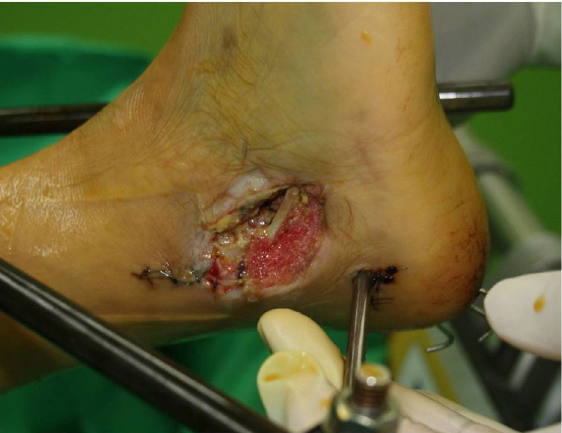
Figure 1. An external fixator with multiple pins and bars may theoretically increase the risk of pin-tract infections. When these pins are closely located to the wounds, it may be difficult to dress and to seal up the wound for a negative pressure therapy when